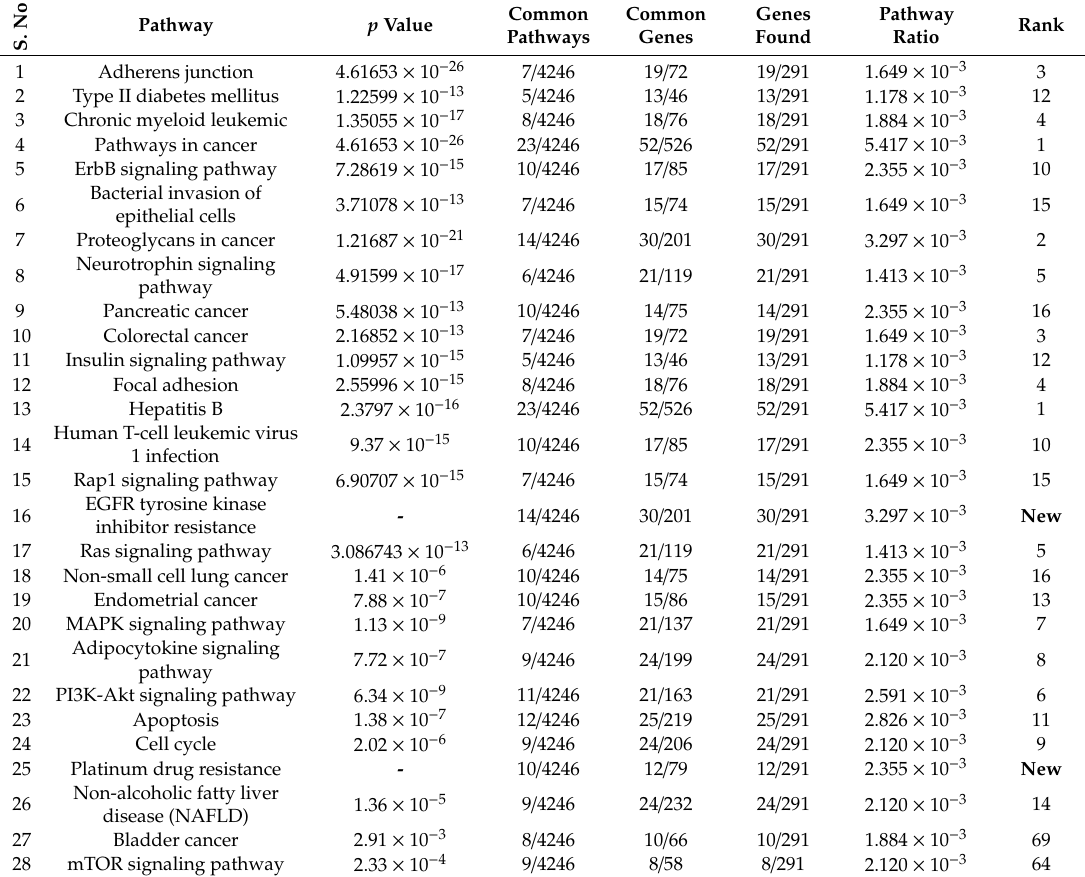
Table 2. PathwayConnector—complementary pathway networks enriched by the HOMA- β